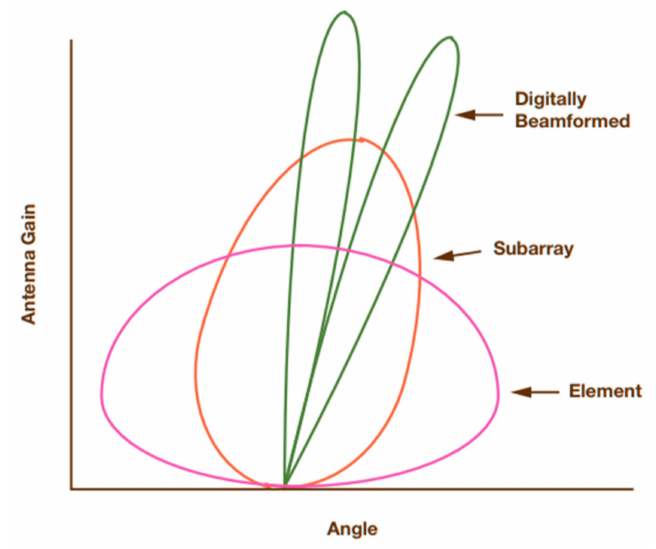
Figure 2. Digital beamforming antenna